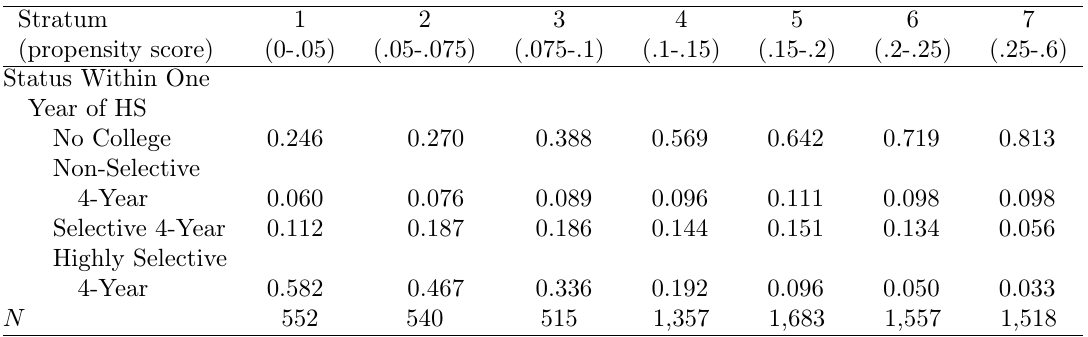
Table 4: Decomposition of Community College Alternatives by Strata-Specific Propensity for